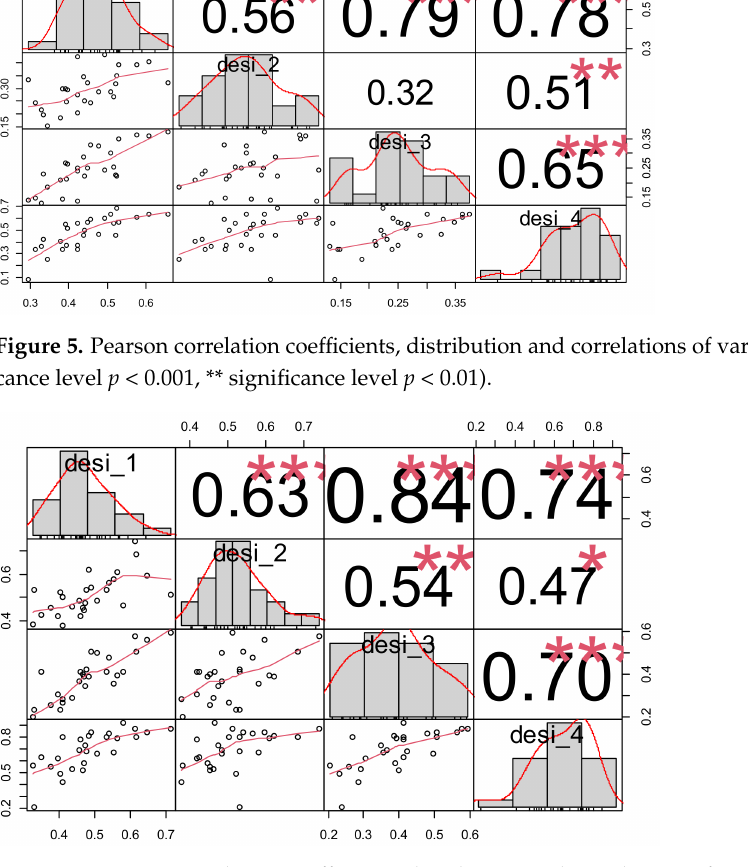
Figure 6. Pearson correlation coefficients, distribution and correlations of variables, 2021. (***